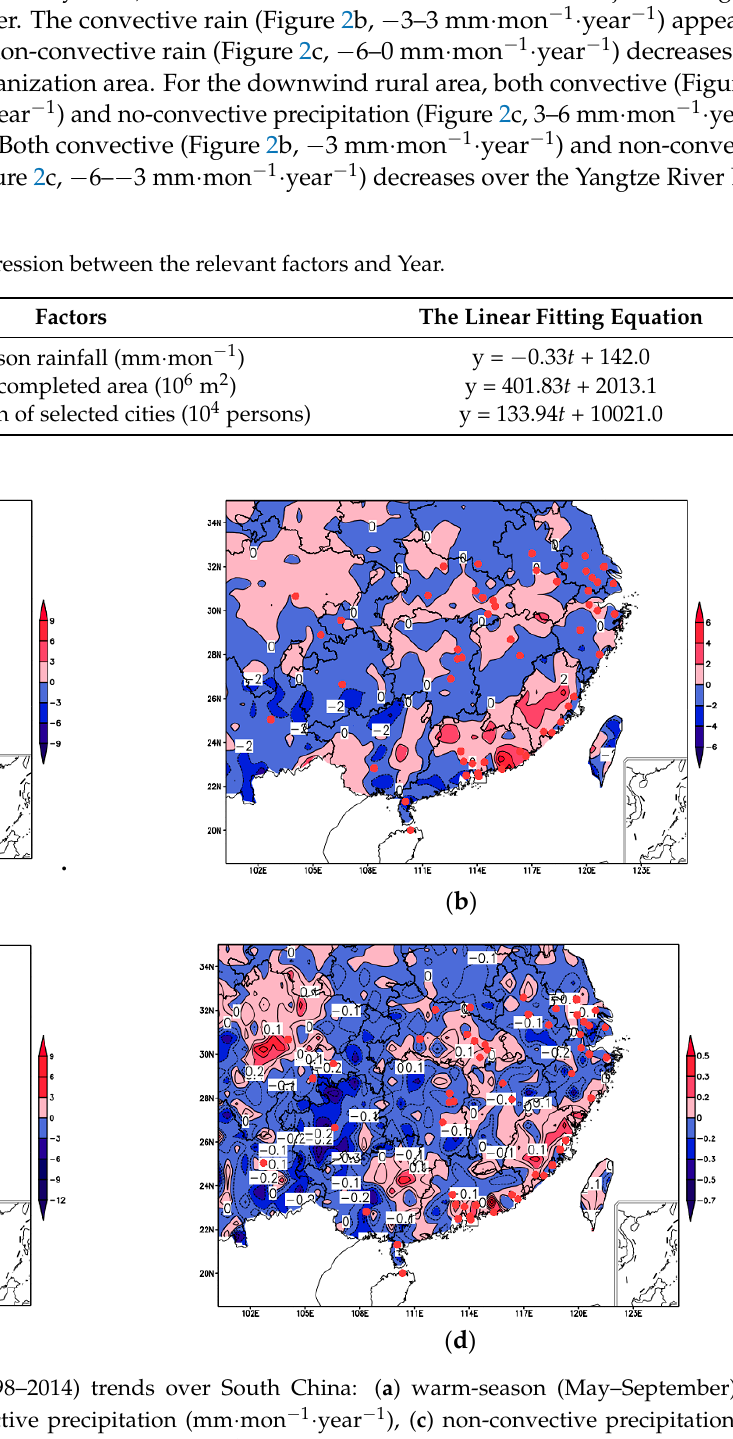
Table 1. Linear regression between the relevant factors and Year.